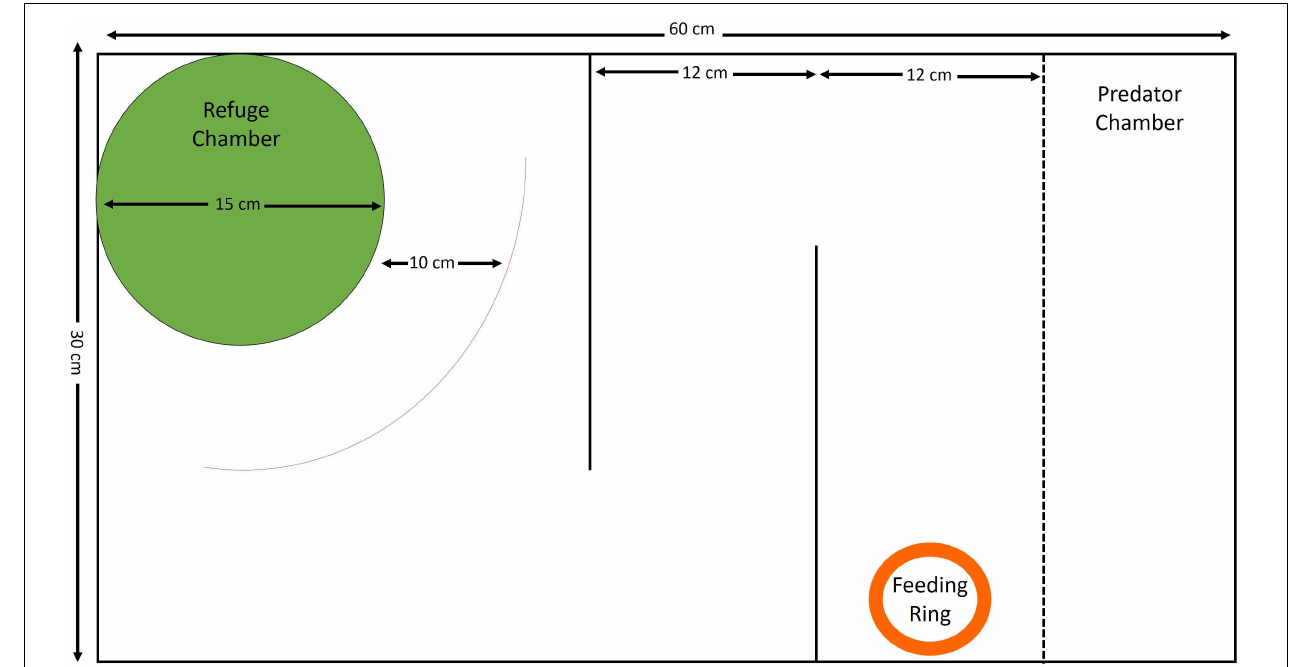
FIGURE 1 | Schematic representation of the setup (top view) with dimensions of each section of the experimental arena.